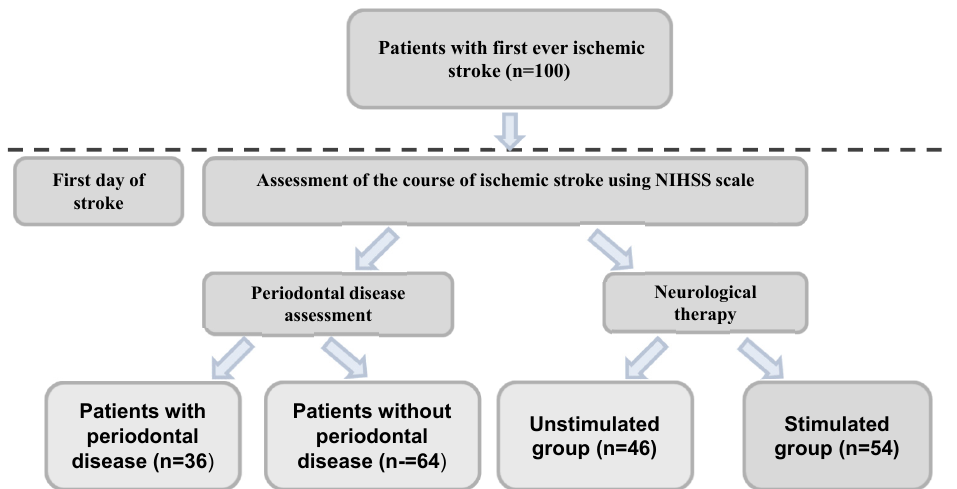
Figure 1. Division of patients with ischemic stroke into specific groups. NIHS—National Institute of Health Stroke Scale.